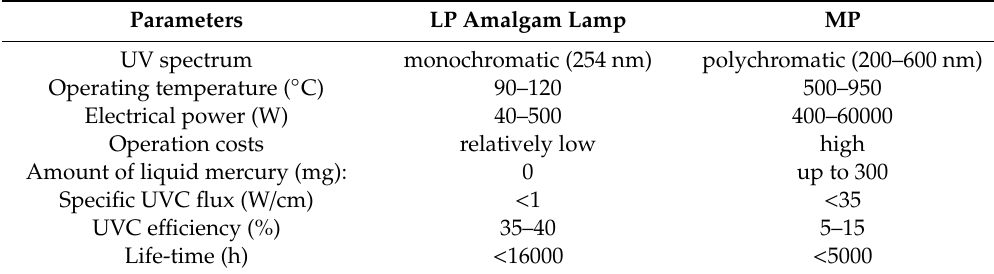
Table 1. Main parameters of low pressure (LP) (amalgam) and medium pressure (MP) lamps